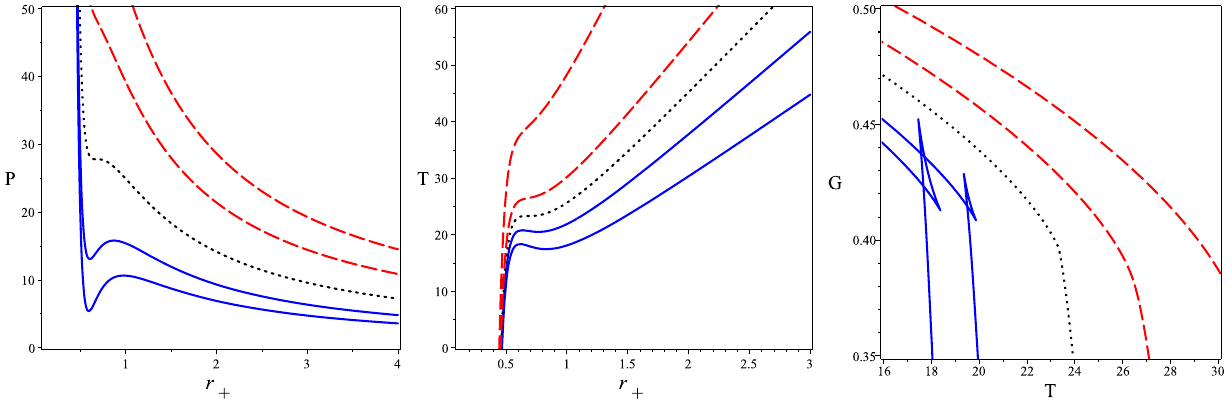
Fig. 19 LM AdS black hole with hyperbolic horizon: P − r + (left), T − r + (middle) and G − T (right) diagrams; we have set k = − 1, d = 7, q = 1, m = 1, c 0 = c 1 = c 2 = c 3 = c 4 = 1 and α = 0 . 01. Left